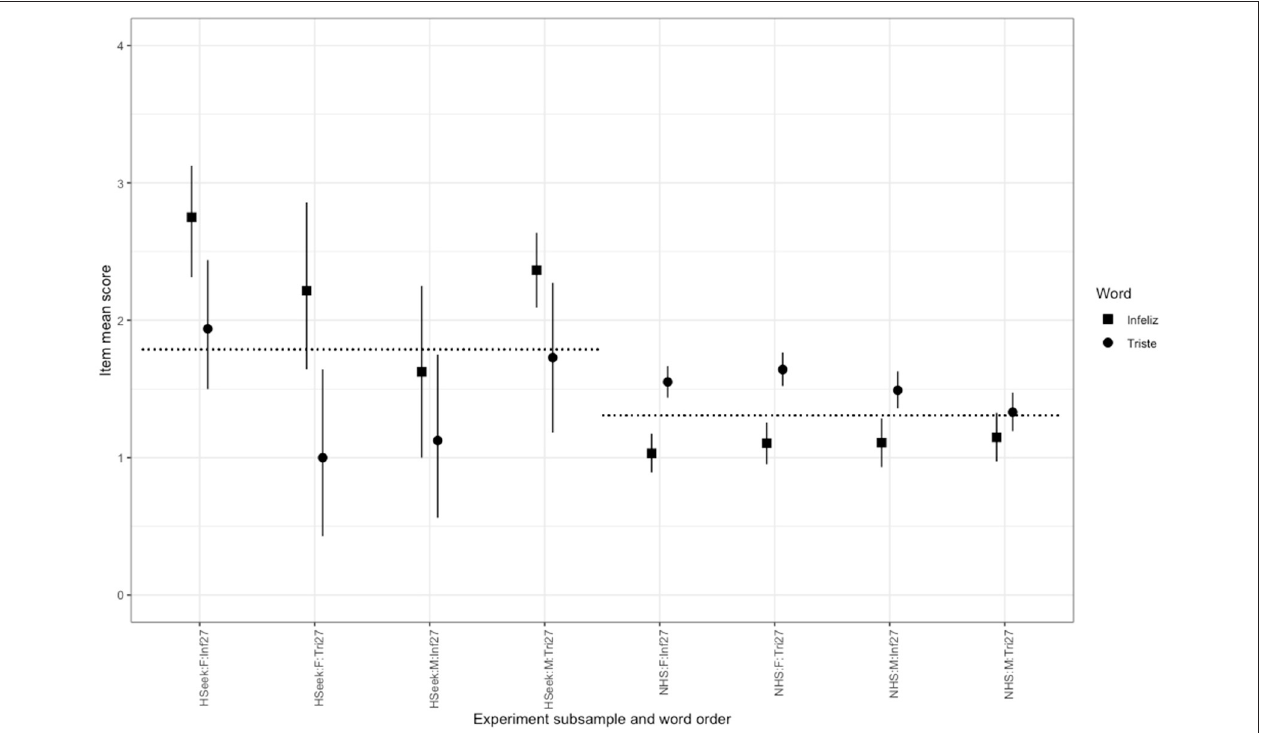
FIGURE 2 | Mean item score by word, sample, gender, and item order. Points mark item mean scores by group, vertical error bars are bootstrapped 95% confidence intervals. Horizontal reference lines are aggregated means for the help-seeking and non-help-seeking samples. Code of subsamples is Sample:Gender:Position specifically: HSeek, help-seeking; NHS, non-help-seeking; Inf27, “ Infeliz ” in item 27; Tri27, “ Triste ” in item 27. Y axis scaled from 0 to 4: the full range of the item.